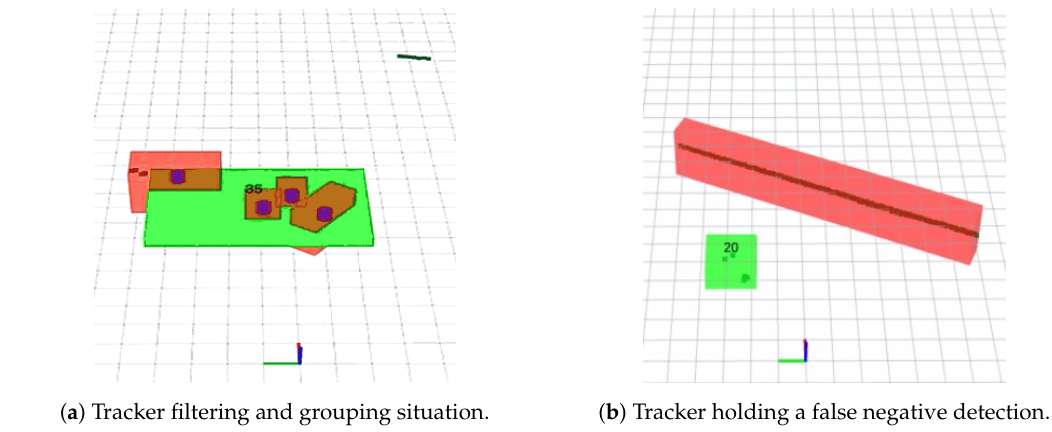
Figure 8. Tracking grouping and holding cases over real data. In green the final moving target with its identifier. Red objects are segmented elements and blue cylinders are dynamic elements tagged by the detector. ( a ) shows how several over-segmented objects are grouped into one unique track in the center of the image. In addition, our tracker can filter a false positively detected dynamic object as seen in the top left corner. ( b ) shows our tracker holding a moving vehicle in a false negative